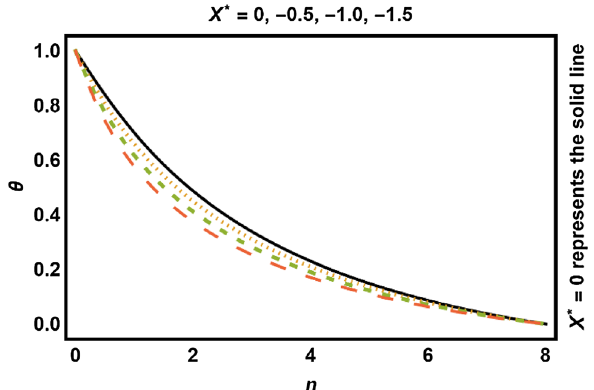
Figure 13. X ∗ < 0 on temperature field.